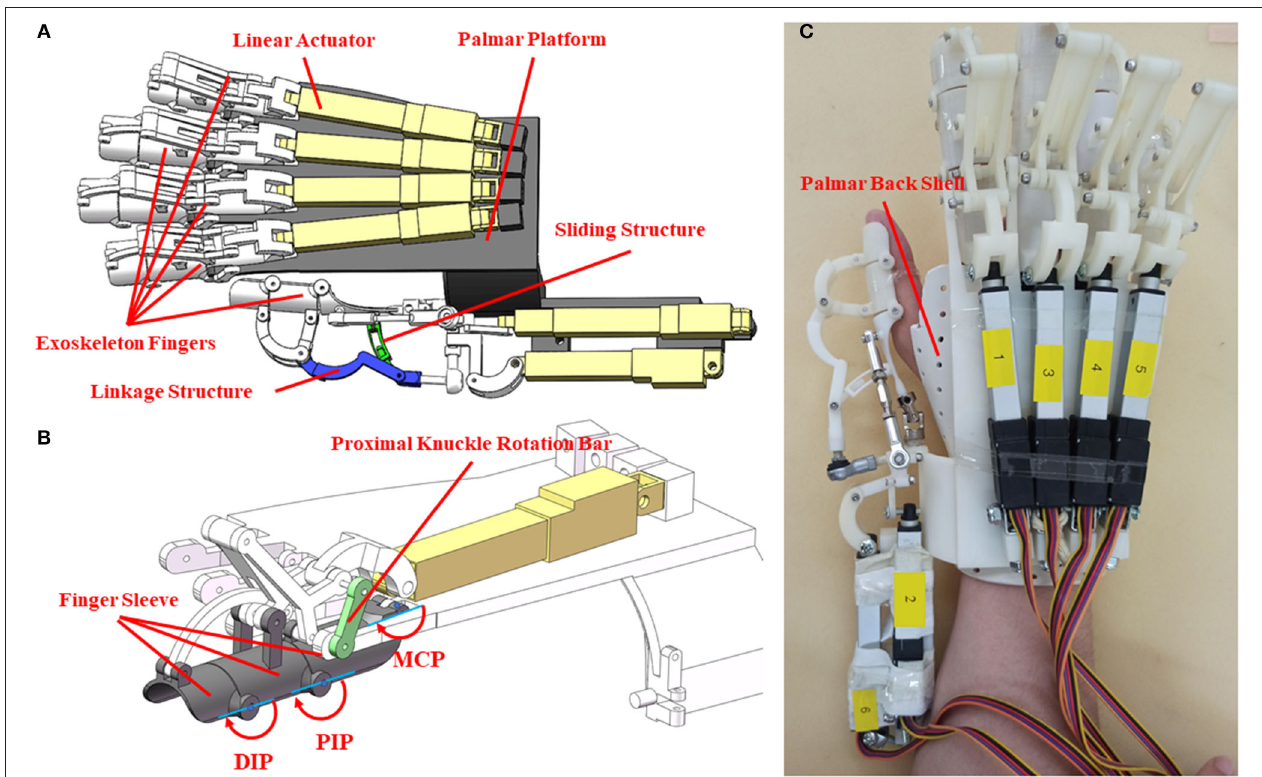
FIGURE 1 | The mechanical design and realization of hand exoskeleton. (A) The mechanical design of the exoskeleton; (B) mechanical structure of exoskeleton index finger; (C) prototype of the hand